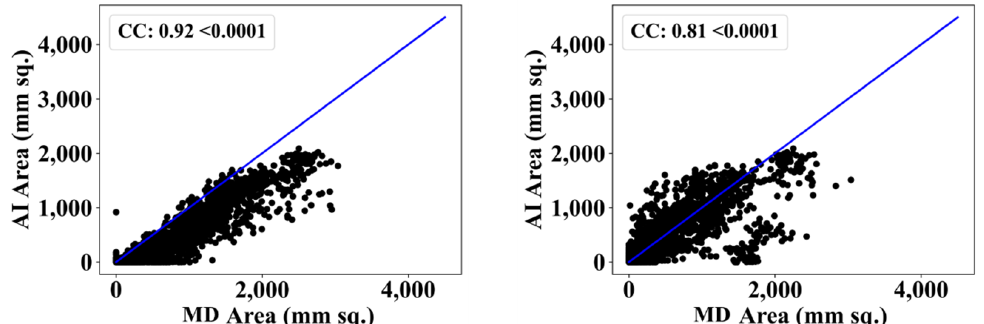
Figure 19. Correlation coefficient plots for (left) PSPNet vs. MD 1 and (right) PSPNet vs. MD 2.